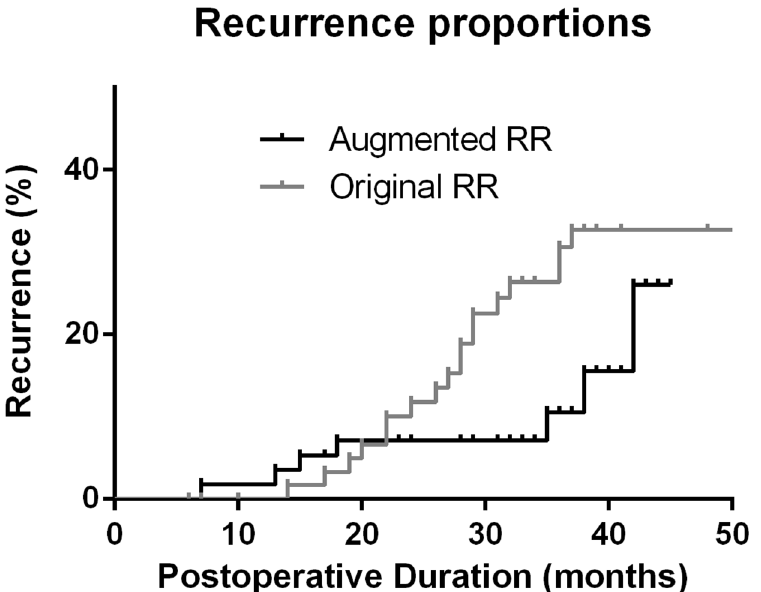
Fig 2. Survival curves. Kaplan-Meier survival curves after the originalunilaterallateral rectus recession- medialrectus resection(RR) and the augmented RR. The cumulativeprobabilityof recurrencewas lower in the augmented RR group at 36 months after surgery ( P = 0.046, log rank